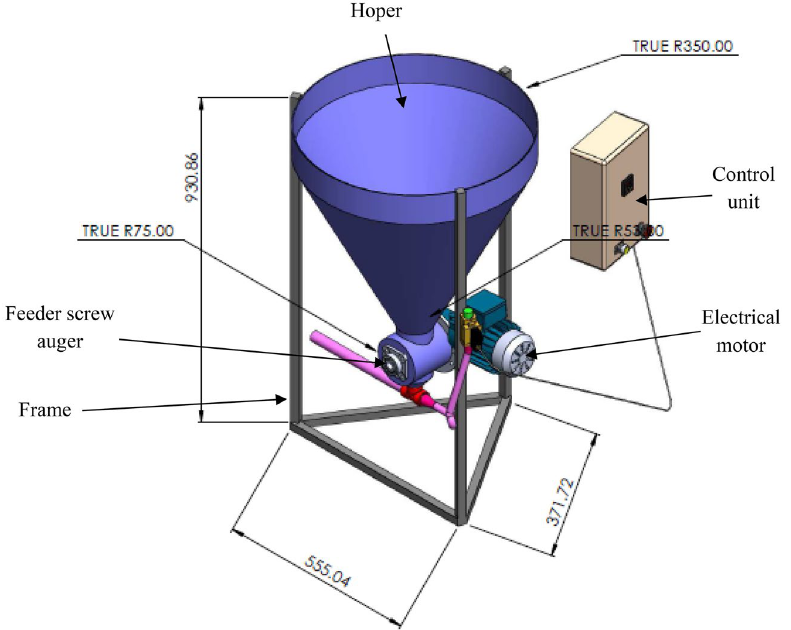
Figure 1. Isometric drawing of the automatic feeder (dimension in